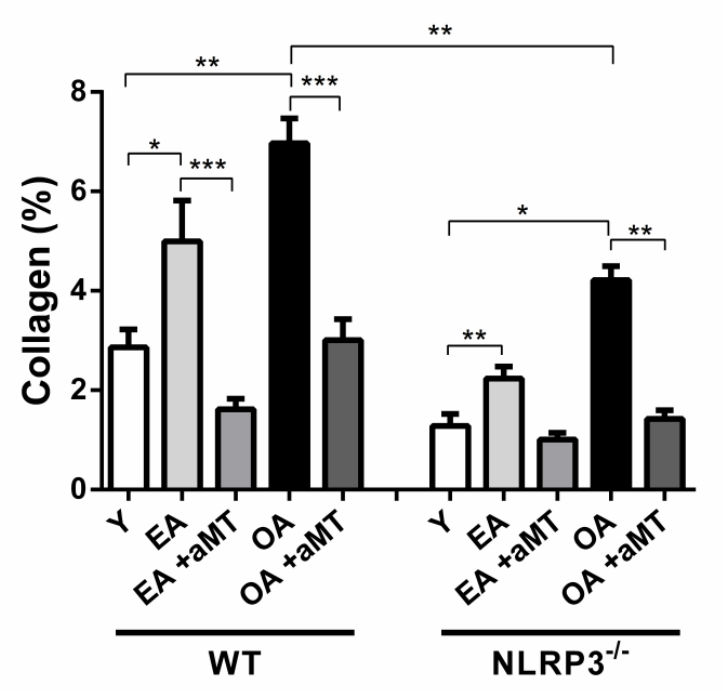
Figure 6. Impact of NLRP3 inflammasome and melatonin supplementation on the collagenous content of the gastrocnemius muscle during aging. Morphometric analysis of the percentage of the collagen in the gastrocnemius muscle of the young (Y), early aged (EA), early aged with melatonin (EA +aMT), old-aged (OA), and old-aged with melatonin (OA+ aMT) WT and NLRP3 − mice revealing that aging induced a significant increase in the percentage of the collagen, and this increase was less considerable in the gastrocnemius muscle of NLRP3 − mice than WT mice. Moreover, melatonin therapy countered age-associated muscular changes and reduced the percentage of collagenous tissues deposition. Comparisons between groups are indicated in the graphs. * p < 0.05, ** p < 0.01 and *** p < 0.001.